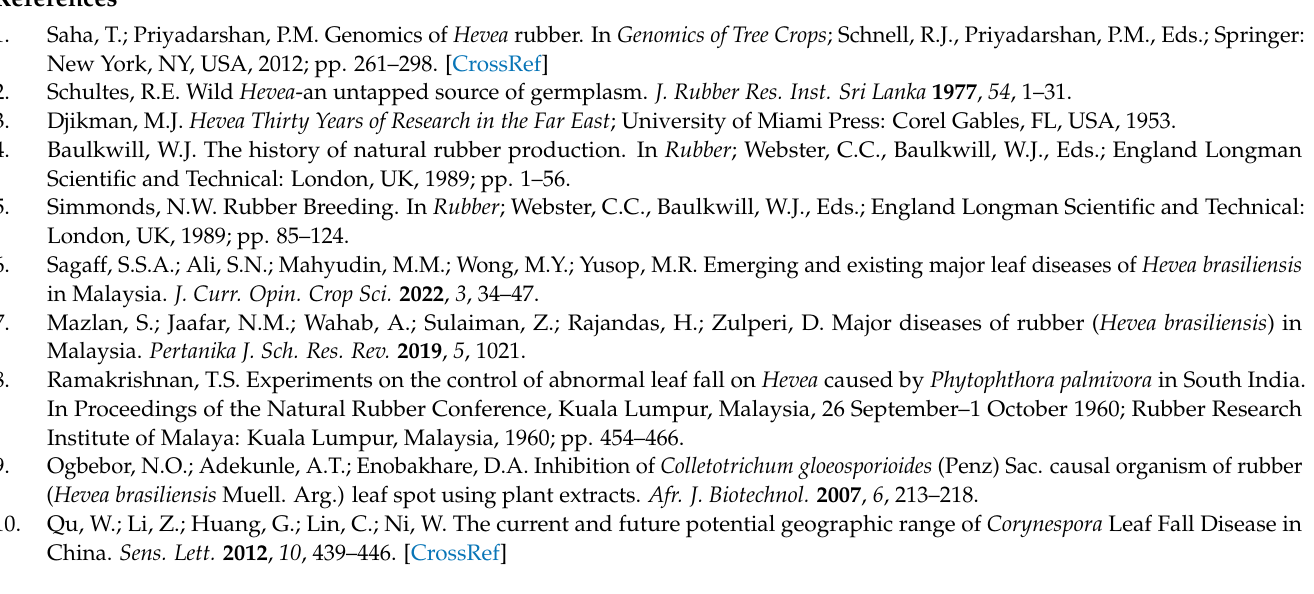
S3: Description of the integrated map. Table S4: Integrated genetic linkage map of Hevea brasiliensis × Hevea benthamiana . Table S5: SNP and SilicoDArT tags aligned with the available rubber genome sequences (Draft genome and reference genome sequences of H. brasiliensis ). Pseudomolecules with a code of “CM” belong to the reference genome sequences of H. brasiliensis and rest belong to the draft genome. Table S6: Markers used in Synteny analysis. Only markers aligned with the H. brasiliensis reference genome sequences were used in this analysis. Table S7: Allele-specific and common primer sequences for the KASP assays using trait-associated SNPs. Table S8: Comparison between KASP calls and DArTSeq calls for the markers 100057258|F|0–6:T > C (WriHK1) and 100061575|F|0-46:G>A (WriHK7). Table S9: Genotypic calls obtained with KASP assays for 178 progeny of Hevea brasiliensis × Hevea benthamiana and phynotypic data for the assayed disease traits. Table S10: Genes predicted with high confidence within a candidate regions on the pseudomolecules of 18, 6 and 14 in the Hevea brasiliensis GT1 reference